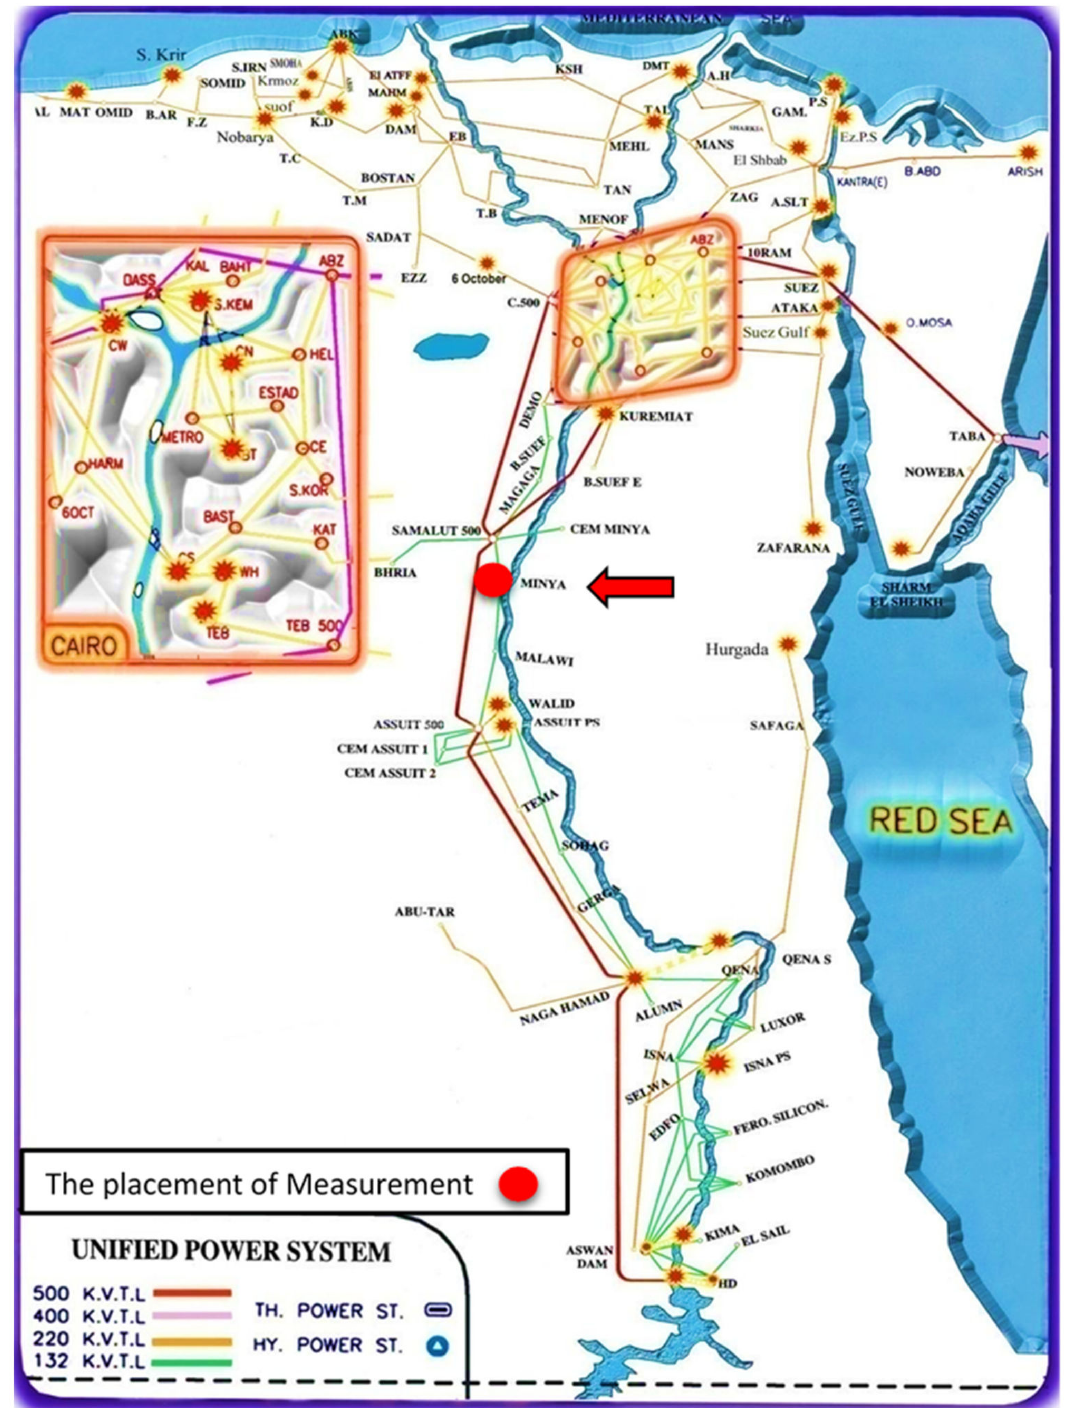
Figure 1. Egyptian Electrical Unified Network